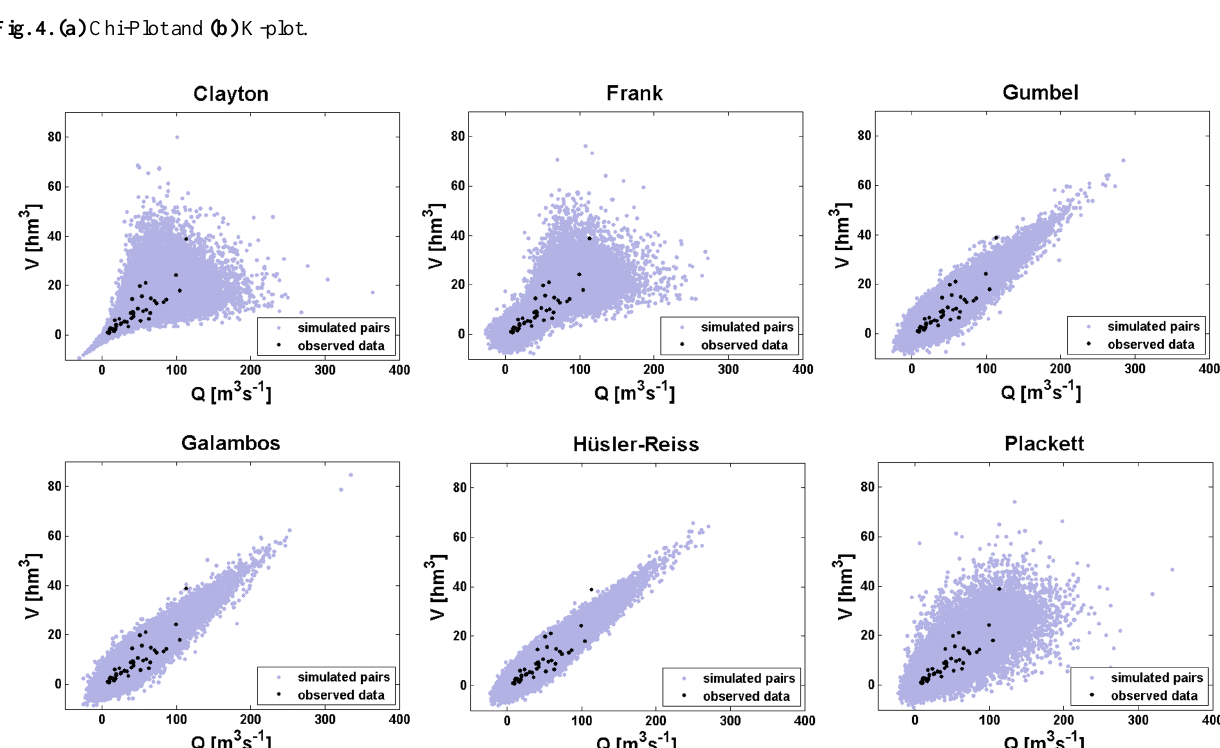
Fig. 5. Scatter plot of 100000 values generated from the copulas fitted by the inversion of Kendall’s tau method and the observed